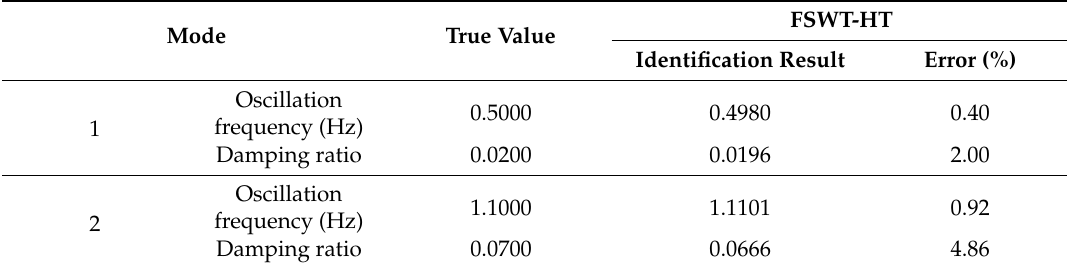
Table 2. LFO mode components parameters after RSSD denoising ( σ =